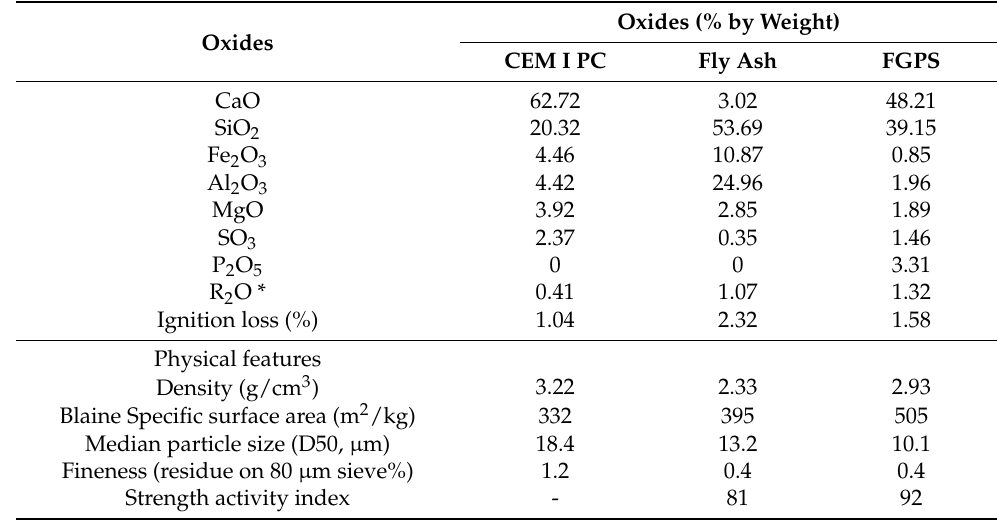
Table 1. Physical characteristics and oxide compositions of cement and fly